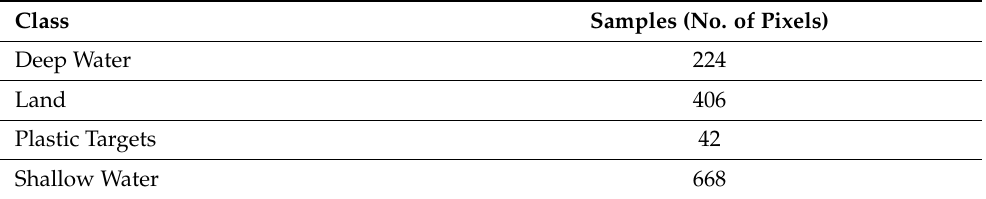
Table 4. Training set distribution per